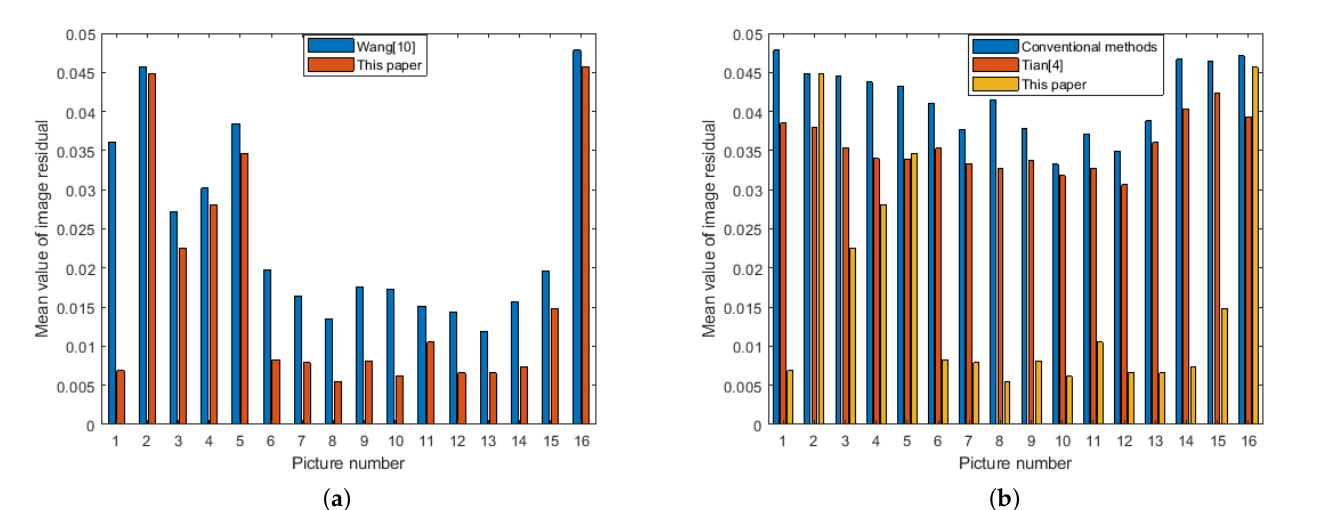
Figure 10. Reprojection error of intermediate camera. ( a ) The method proposed in this paper is compared with the same type of method; ( b ) The proposed method is compared with other algorithms.